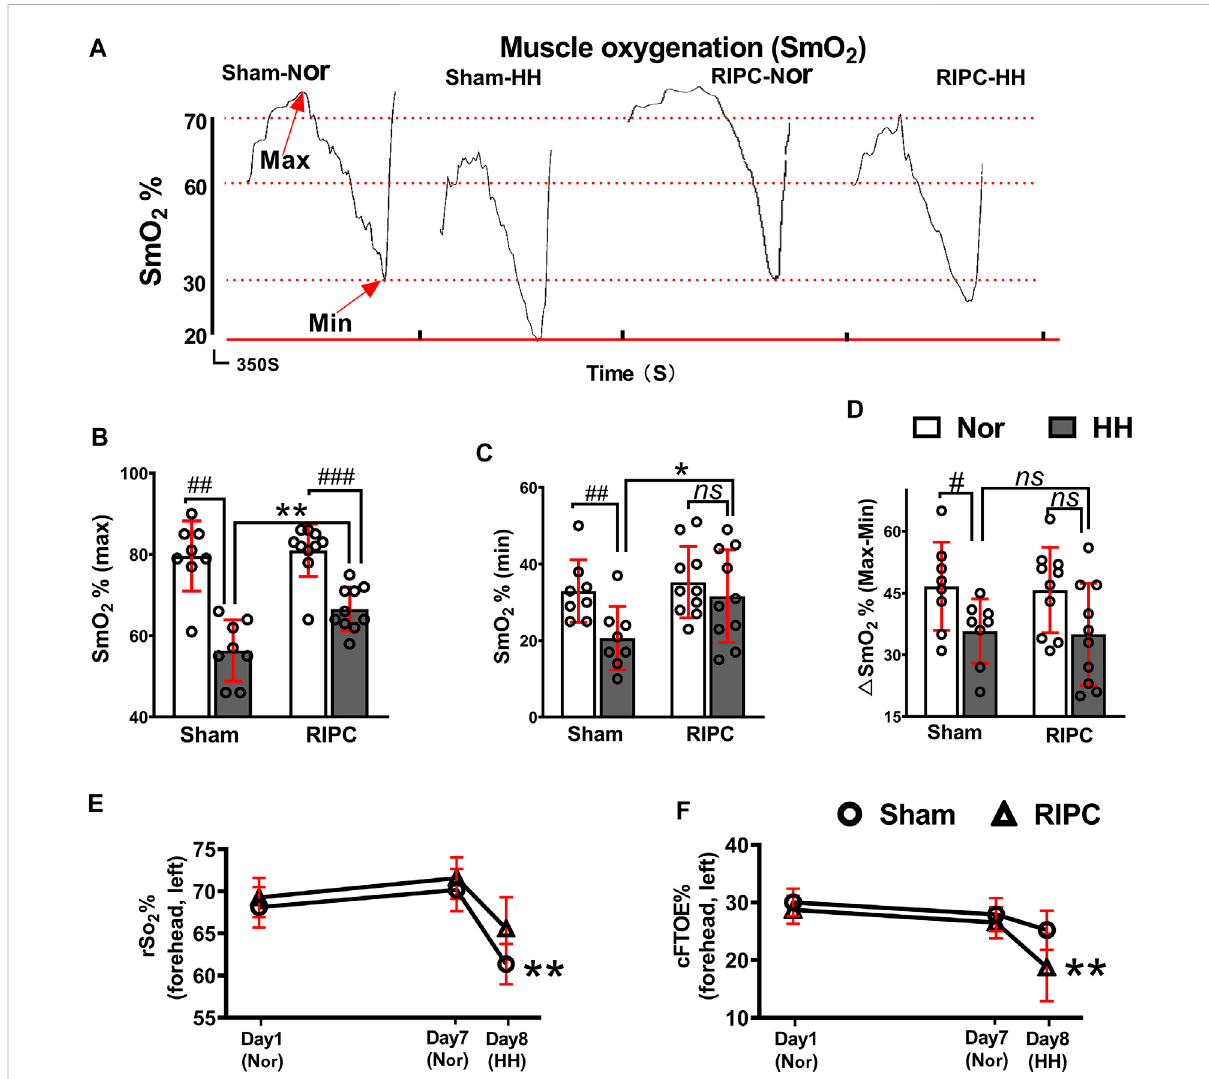
FIGURE 4 The bene fi cial effects of RIPC on SmO 2 and rSO 2 . (A) SmO 2 results from representative participants under different environments. (B) The maximum, (C) minimum, and (D) Δ SmO 2 from the normoxic to HH condition in each group. # p < 0.05, ## p < 0.01, ### p < 0 .001 vs. normoxic; * p < 0.05 and** p < 0.01vs.shamgroup. (E) VariationofrSO 2 %and (F) cFTOE% intheshamandRIPCgroups atday1,day7,andday8intheleftbrain. ** p < 0.01 vs. sham group. Values are presented as mean ± standard deviation. Nor: normoxic, HH: hypobaric hypoxia, SmO 2 : muscle oxygenation, rSO 2 : regional cerebral oxygenation, cFTOE: cerebral fractional tissue oxygen